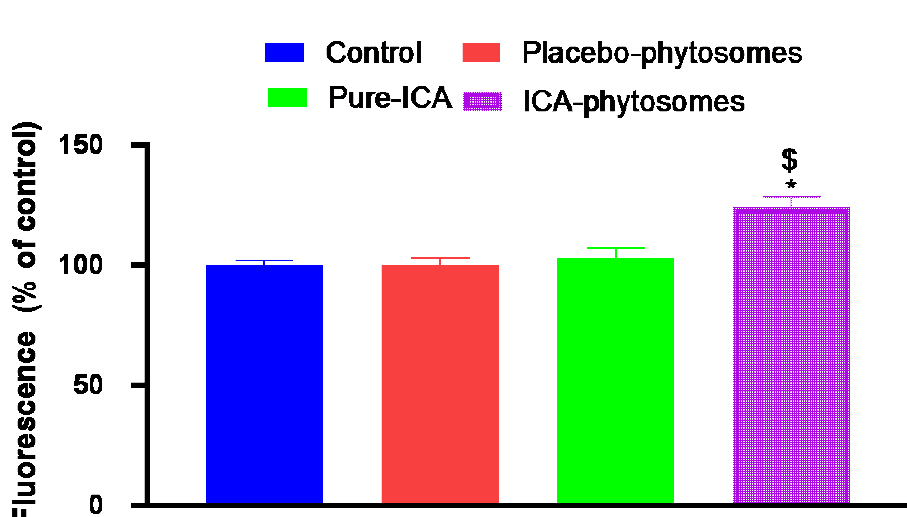
Figure 11. Bar diagram of fluorescence during reactive oxygen species (ROS) determination. * Significantly different from control at p < 0.05, # significantly different from placebo-phytosomes at p < 0.05, $ significantly different from pure-ICA at p <